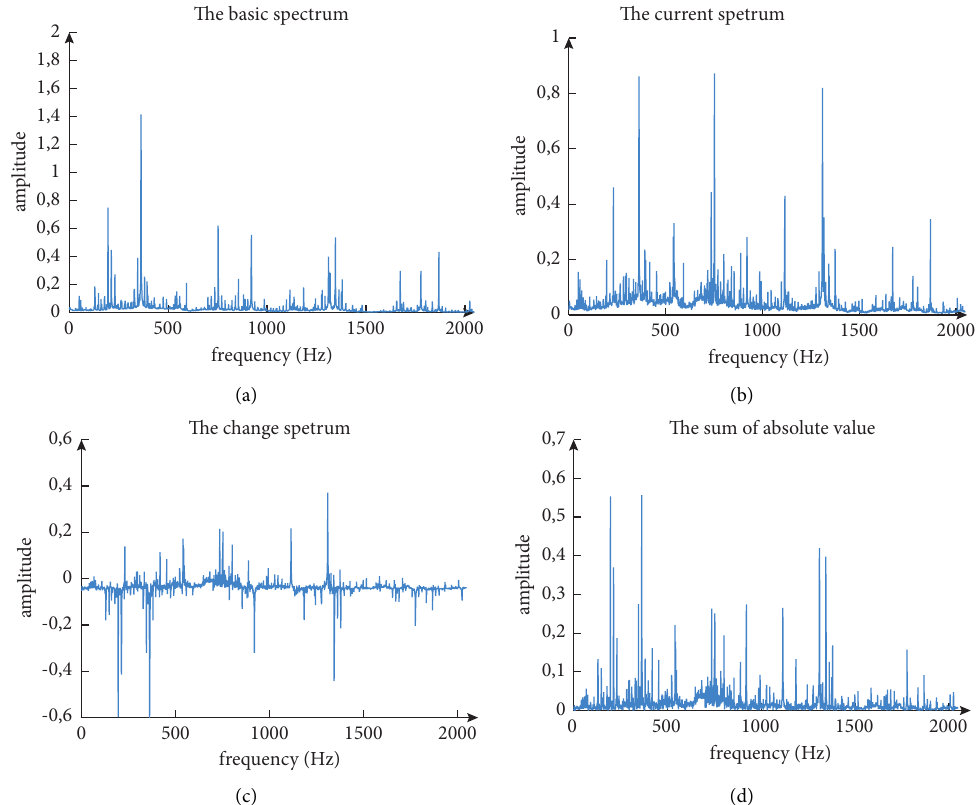
Figure 6: Frequency domain signal and offset tolerance calculation.